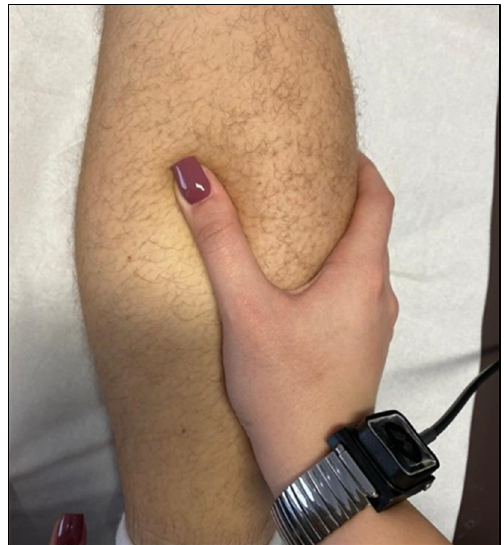
Figure 7. TECAR therapy with massaging calf